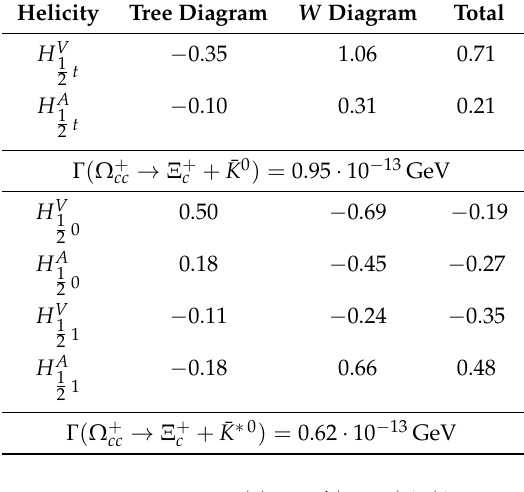
Table 5. Decays Ω + cc → Ξ + c + ¯ K 0 ( ¯ K ∗ 0 ) .